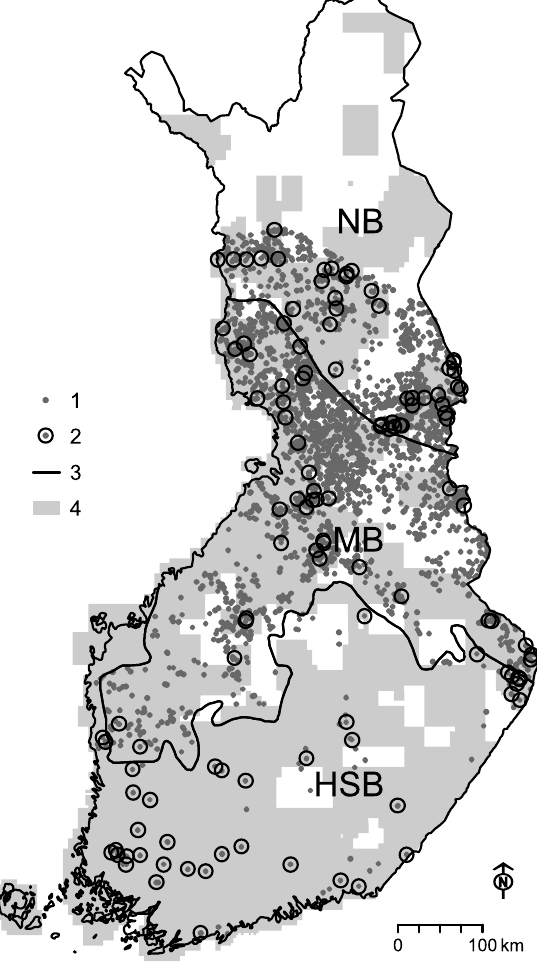
Figure 4. Aapa mire samples and their source population. Legend: (1) undrained peatland patch with aapa features and more than 50 ha in size; data for northernmost Finland unavailable; (2) sampled aapa mire; 40 for each climate zone, giving a total of 120; (3) climatic-phytogeographic zone border; HSB = hemiboreal and southern boreal zone, MB = middle boreal zone, NB = northern boreal zone; (4) extent of digital elevation model (base map: